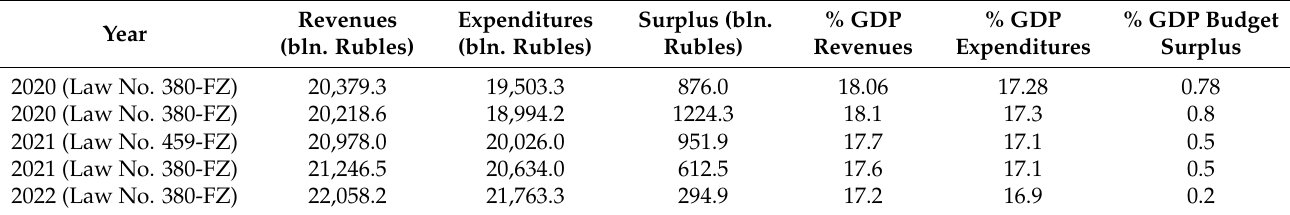
Table 1. The federal budget of 2020–2022: main